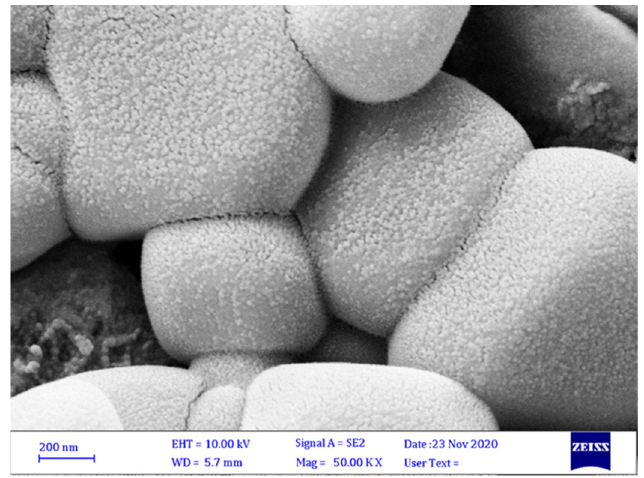
Figure 5. Scanning electron micrograph of microcapsules. SEM revealed that most microcapsules were cubic with quite homogeneous morphology.